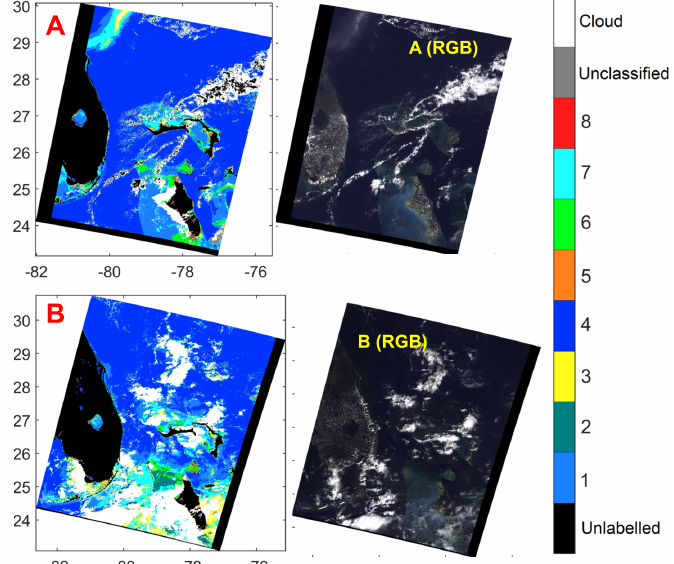
Figure 9. Classification results using MERIS’s raw radiometric data. Data of scene A was taken on 7 May 2011, 15:21 p.m. Data of scene B was taken on 29 September 2005, 15:39 p.m. The Red-Green-Blue (RGB) projections of the three scenes are also